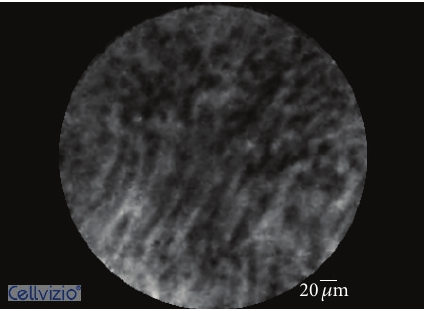
Figure 3: Probe-based confocal laser endomicroscopy imaging showing increased space between scales.